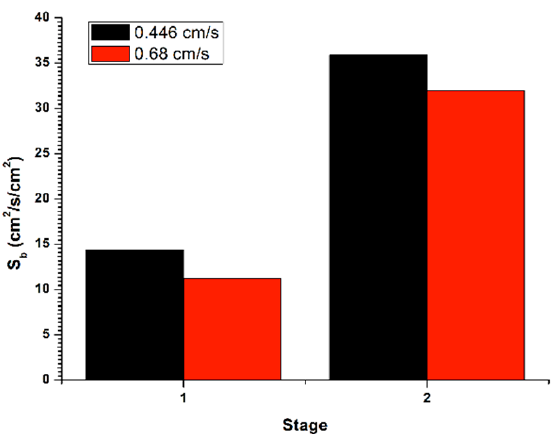
Figure 6. Determination of S b in the batch flotation column of the material of the Dos Carlos dam, for J lT of 0.446 & J lT of 0.68 cm / s, 50 ppm C 12 H 25 NH 2 , as a collector and 60 ppm MIBC as foaming agent.